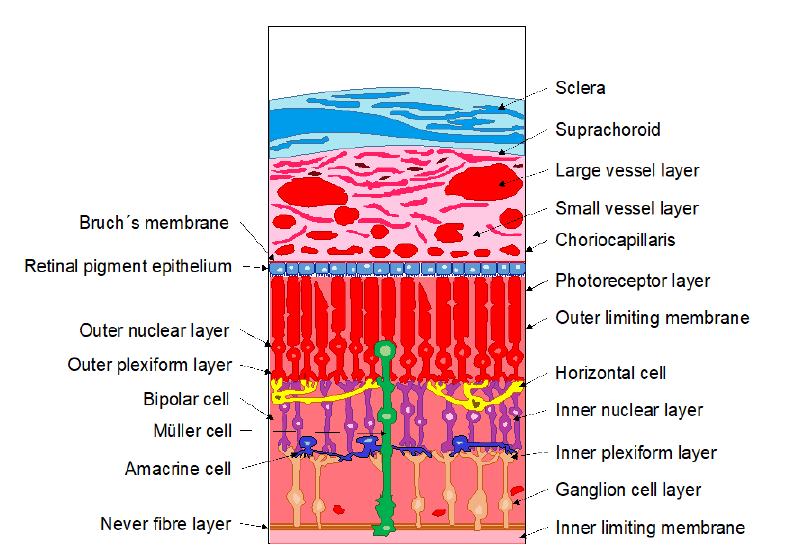
Figure 3. Schematic drawing of the sclera, choroid, and retina.